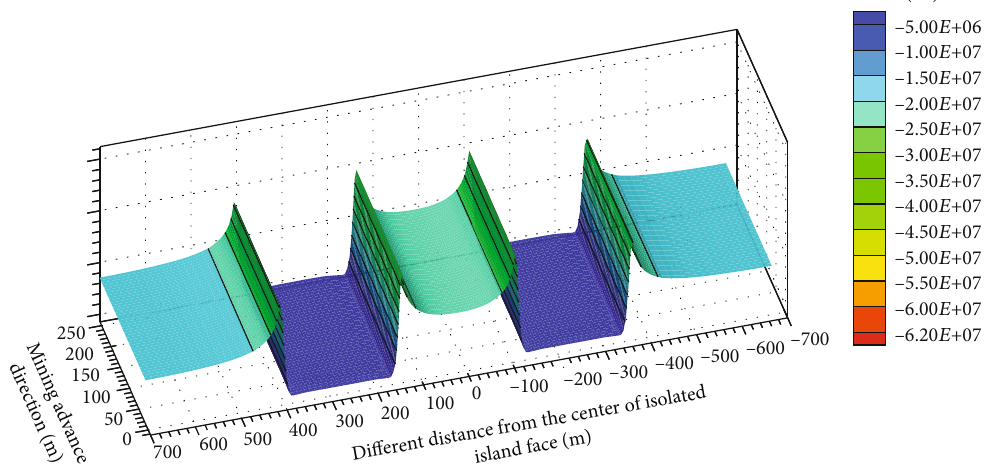
Figure 3: Distribution characteristics of lateral mining stress in the isolated island face.